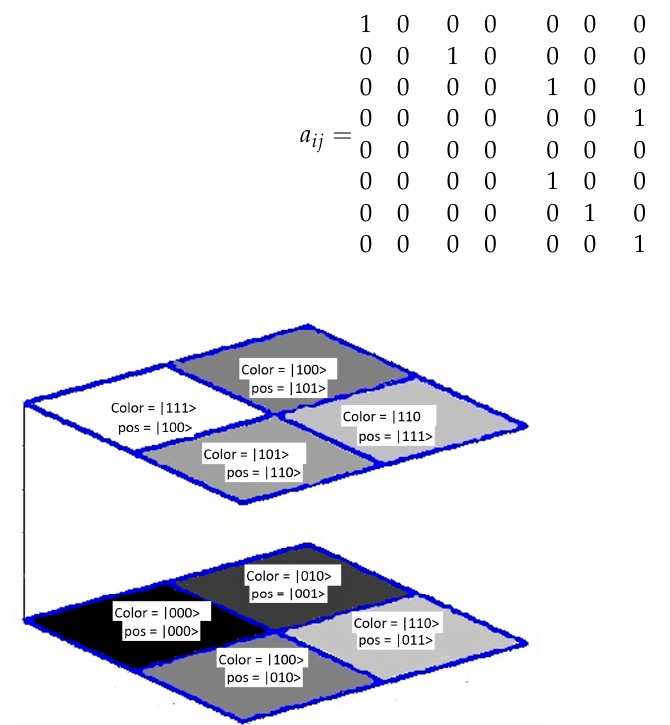
Figure 10. This is an example of 2 × 2 × 2 quantum cube with eight different colors. Three qubits are used to represent color information and three-pixel position information.